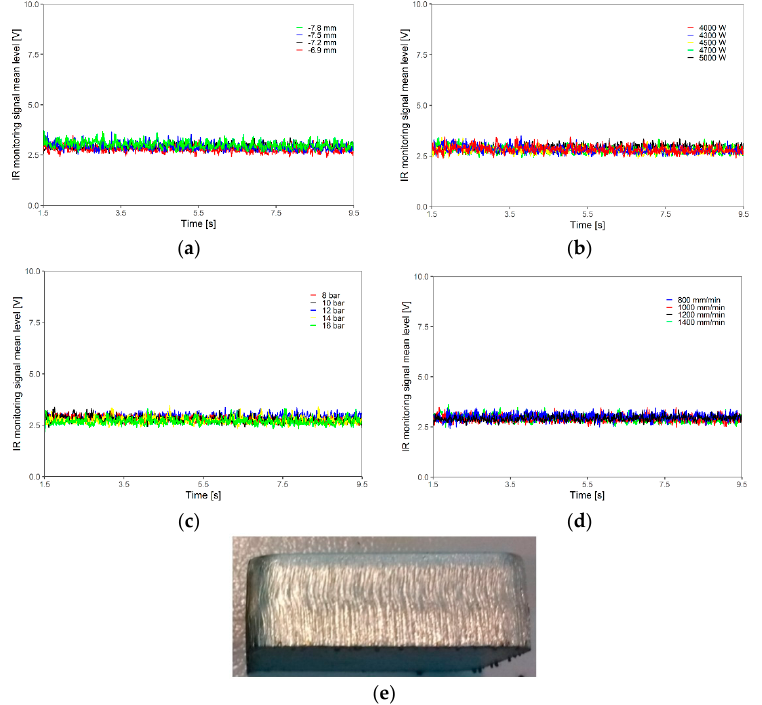
Figure 3. IR monitoring mean levels (gain 1) obtained during the laser cutting of stainless steel of 10 mm with nitrogen, comparing the ideal cutting conditions (black line) with variations in: ( a ) focal position; ( b ) laser power; ( c ) gas pressure; and ( d ) velocity. ( e ) Optical image of a cut sample with the ideal cutting parameters.